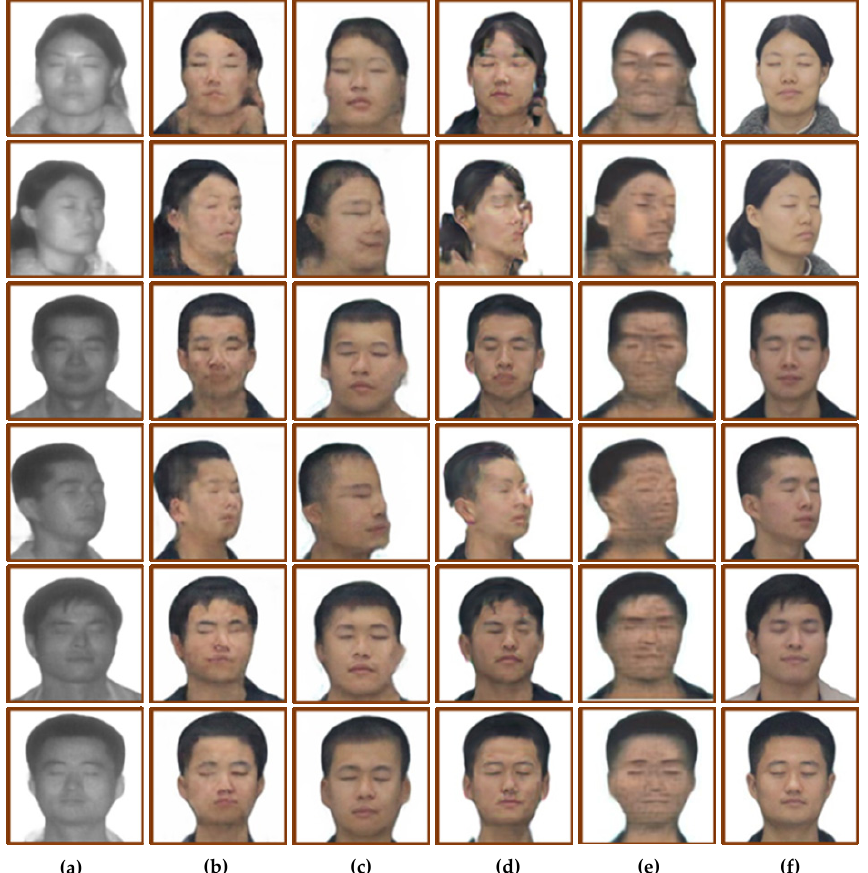
Figure 8. Four models generate face image results. ( a ) Input laser image. ( b ) CycleGAN. ( c ) Pix2pix.